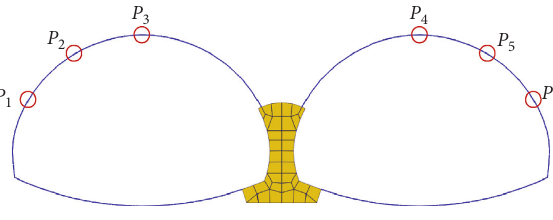
Figure 9: Controlling points of initial